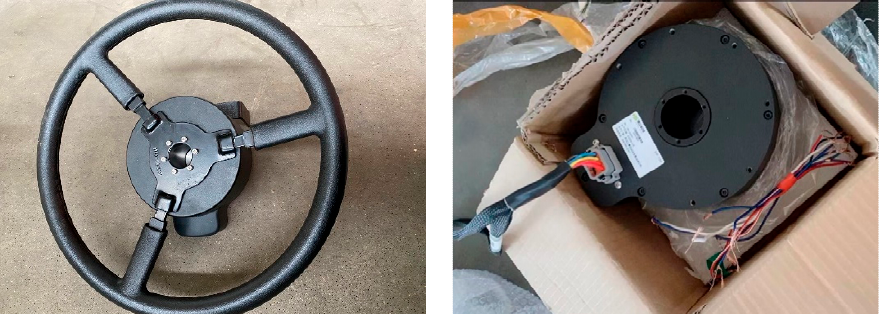
Figure 14. Electric steering wheel motor speed debugging part of the test equipment.